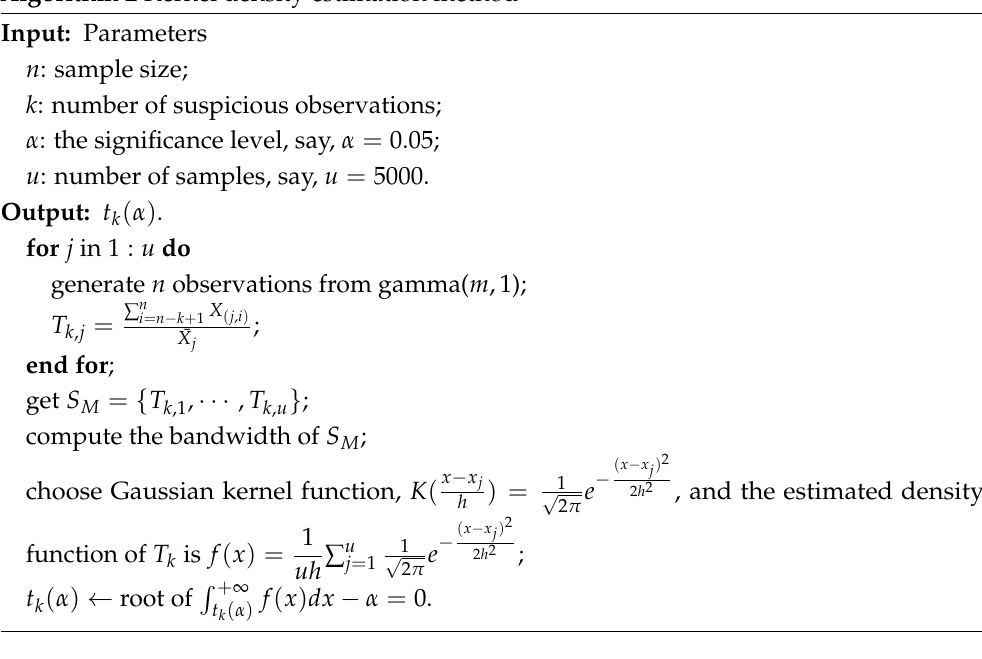
Algorithm 2 Kernel density estimation method